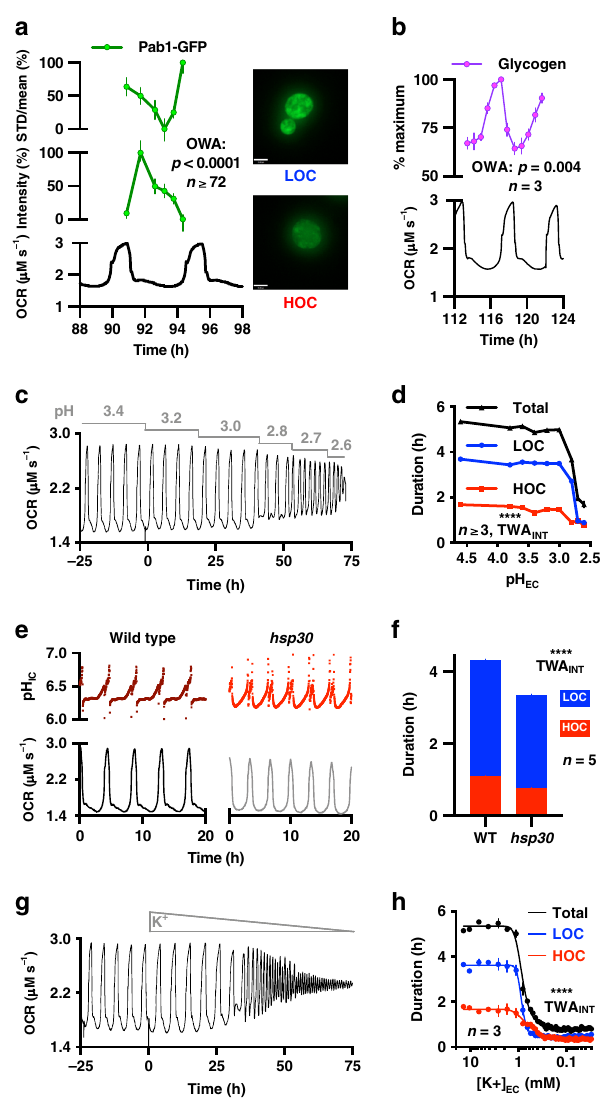
Fig. 4 YROs regulate stress granules and glycogen, and are sensitive to H + and K + . a The intensity and distribution (STD/mean) of stress granule marker Pab1 (Pab1-GFP signal) varies over the YRO, with more foci during LOC and more diffuse during HOC, supporting dynamic variation in stress granule formation (The scale bar represents 1 µ m. OWA, n T90h = 4 images and n T92-97h = 8 images one experiment, n ≥ 72 granules per time point). b Cellular glycogen stores increase during LOC and decrease during HOC (OWA, n = 3 biological replicates). Liquidation of storage carbohydrates is likely to fuel translational bursting during HOC. c , d Decreasing extracellular pH reduces the period of the YRO duration (representative OCR, n pH3.4 = 4 or n = 3 independent experiments). e , f HSP30 mutants have truncated oscillations (maroon/red, pH IC ; black/grey, representative OCR, n = 4 biological replicates). g , h Extracellular K + concentration determines YRO period duration (representative OCR). This is unlikely to be due to loss of cell viability as YROs are rapidly restored when potassium becomes available (representative OCR). All data are shown as mean ± SEM. Source data are provided as a Source Data fi